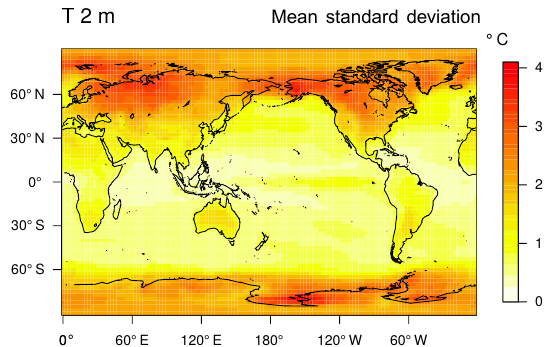
Figure 1. Map of the common normalisation factor. Shown is the mean standard deviation of 2m temperature ( ◦ C) across all the data